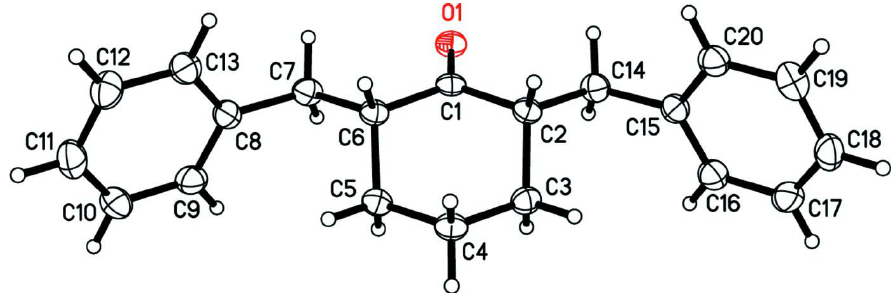
Figure 1 A view of the molecule with the atom numbering scheme. Displacement ellipsoids are drawn at the 50% probability level. cis